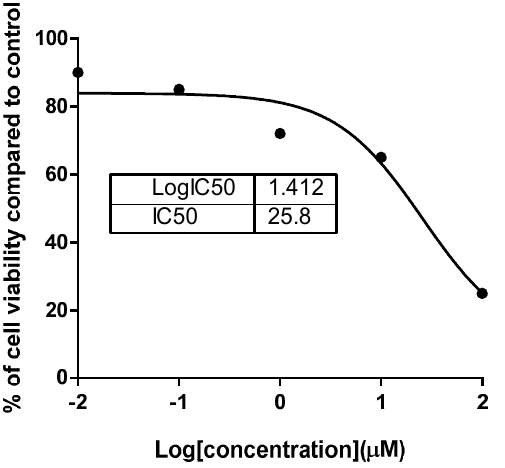
Figure 4. Nonlinear regression dose-inhibition curve fit of compound 1 against MCF-7 using GraphPad Prism 7 software.